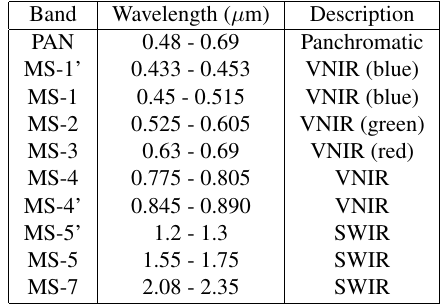
Figure 2: Flow chart of the PHISA